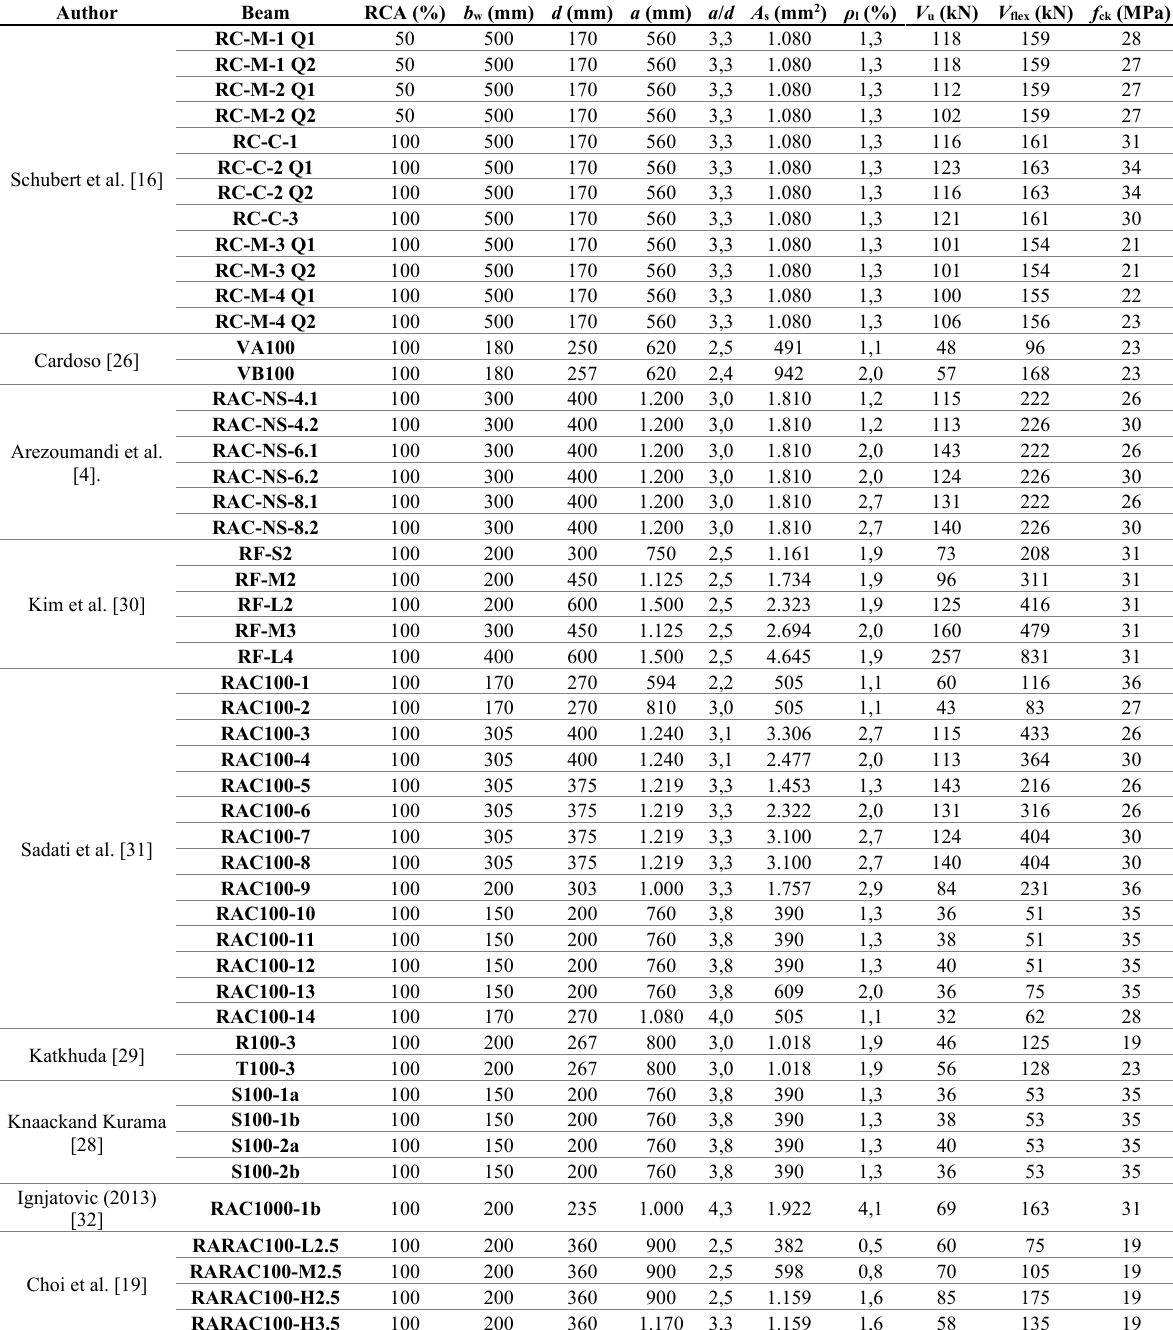
Table A2. Database of tests on reinforced concrete beams without shear reinforcement